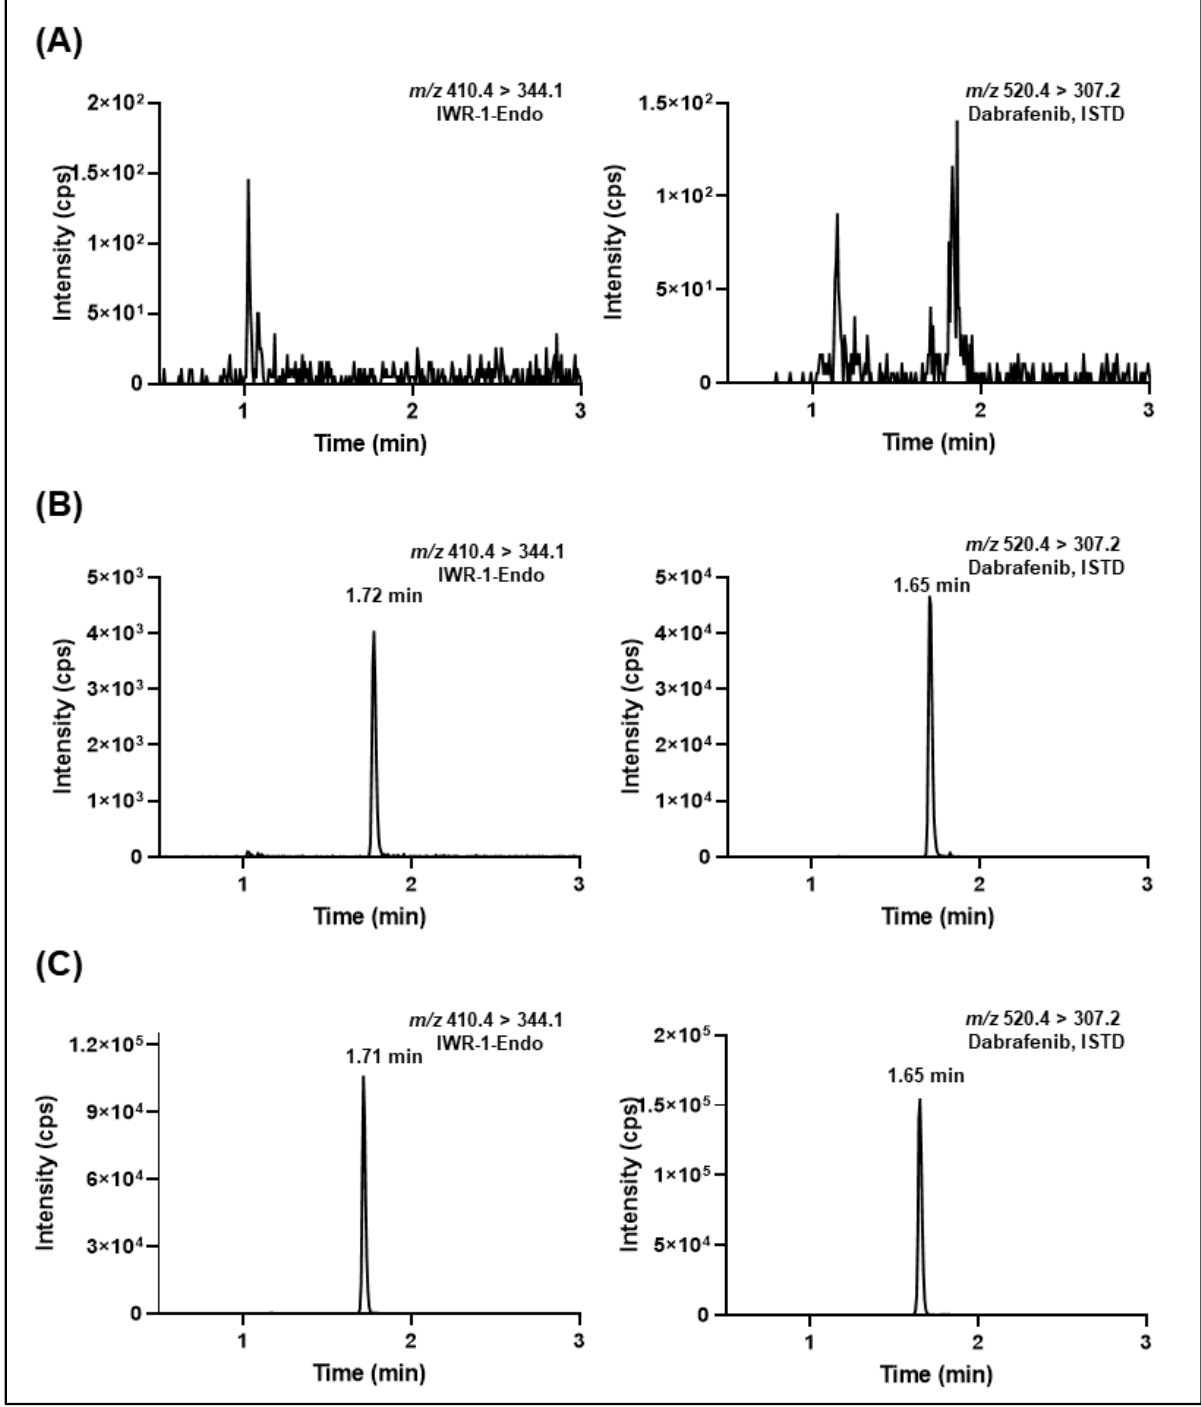
Figure 5. Representative extracted-ion chromatograms of ( A ) murine blank plasma, ( B ) IWR-1-endo-spiked murine plasma sample at LLOQ (5 ng/mL) with ISTD added, and ( C ) 1 h plasma sample from the microdialysis study (ISTD added) after administration of 30 mg/kg IWR-1-endo intraperitoneally.